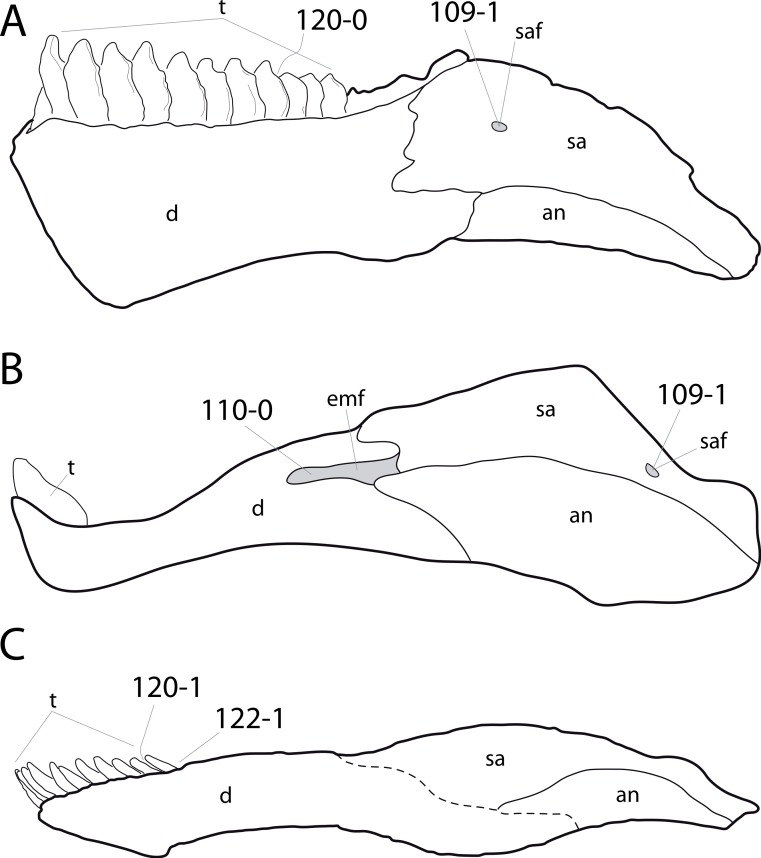
Neosauropod lower jaw.Left lower jaw of Camarasaurus lentus CM 11338 (A; modified from Madsen, McIntosh & Berman, 1995), Nigersaurus taqueti MNN GAD-512 (B; traced from Sereno et al., 2007), and Galeamopus sp. SMA 0011 (C) in lateral view. Note the surangular foramen in A and B (C109-1), the external mandibular fenestra in Nigersaurus (B; C110-0), the strongly overlapping teeth of Camarasaurus (A; C120-0) in contrast to the more widely spaced teeth of diplodocids (C; C120-1), and the anterior inclination of the diplodocid teeth in respect to the jaw axis (C; C122-1). Abb.: an, angular; d, dentary; emf, external mandibular fenestra; sa, surangular; saf, surangular foramen; t, tooth. Scaled to the same mandibular length.